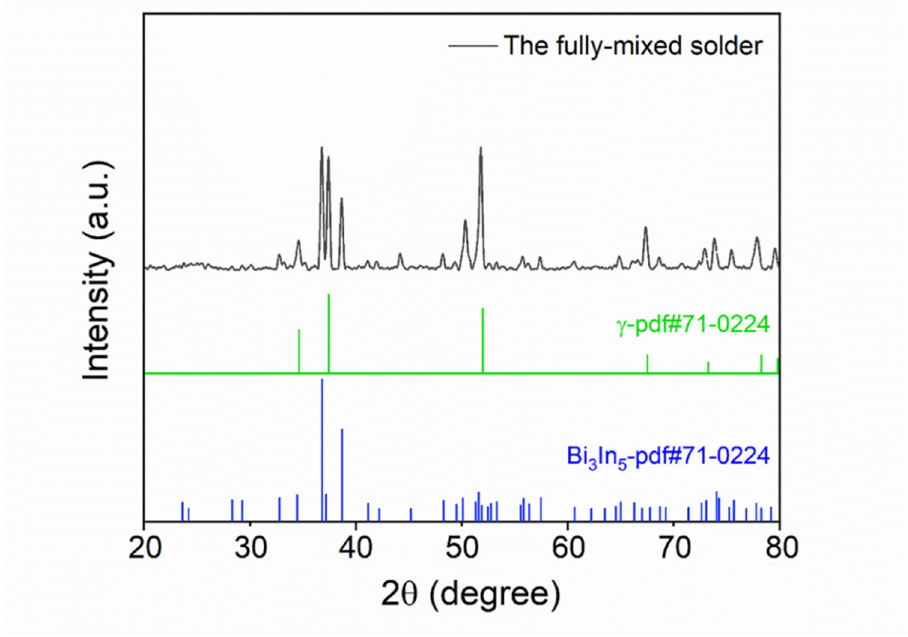
Figure 8. XRD analysis results of the mixed solder joint formed by SAC305 and 13.5Sn-37.5Bi-45In-4Pb after reflowing at 140 °C for 5 minutes.